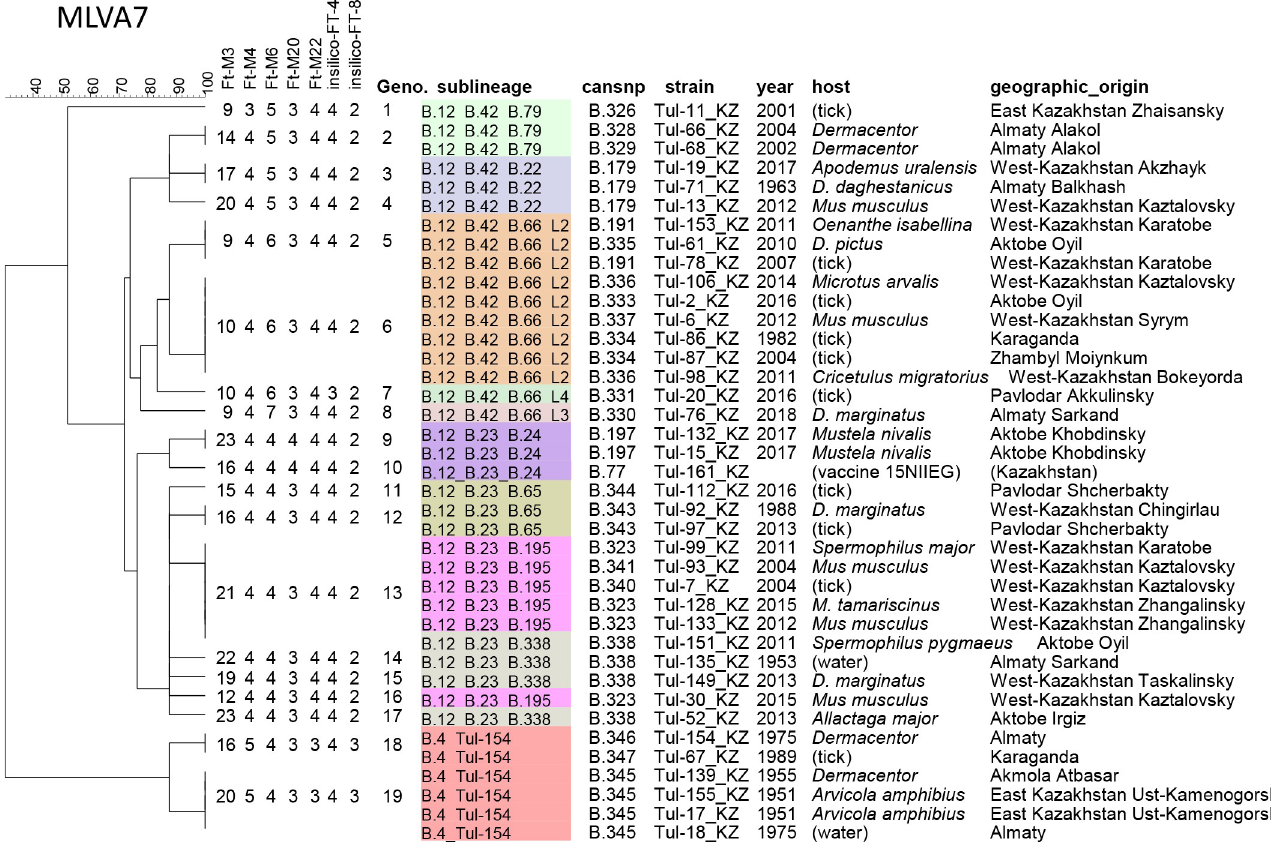
Fig 3. MLVA clustering of the 39 Kazakhstan strains. The MLVA data for the seven polymorphic loci was clustered using the UPGMA method. The main canSNP sublineages are colored.